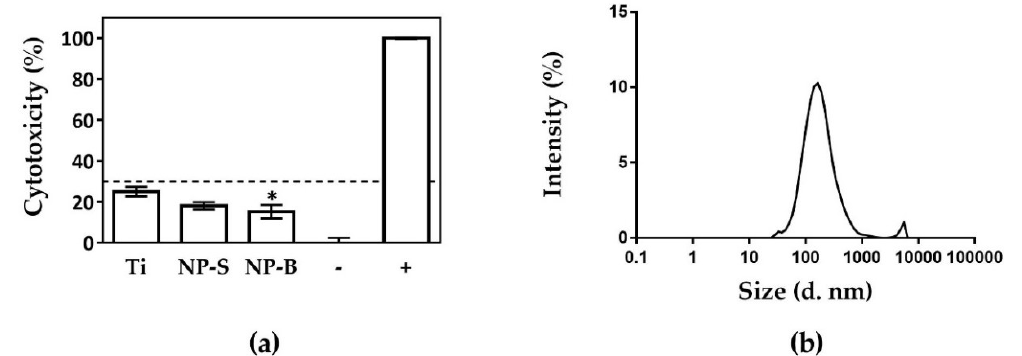
Figure 2. Analysis of cytotoxicity of human gingival fibroblast cells seeded on Ti and TiO 2 nanoporous surfaces. ( a ) Lactate dehydrogenase (LDH) activity measured from culture media of hGF cells seeded on different surfaces after 48 h, was measured for evaluation of cytotoxicity. The positive control (100%) was cell culture media from cells seeded onto tissue culture plastic and incubated with 1% Triton X-100. The negative control (0%) was cell culture media from cells seeded on tissue culture plastic without any treatment. Mean ± S.E.M ( n = 12) are represented. Differences between groups were assessed by ANOVA and post-hoc LSD test: * p < 0.05 versus Ti. ( b ) Particle-size distribution (nm) versus percentage of particle intensity determined by dynamic light scattering (DLS) of NP-B nanoparticle test release.